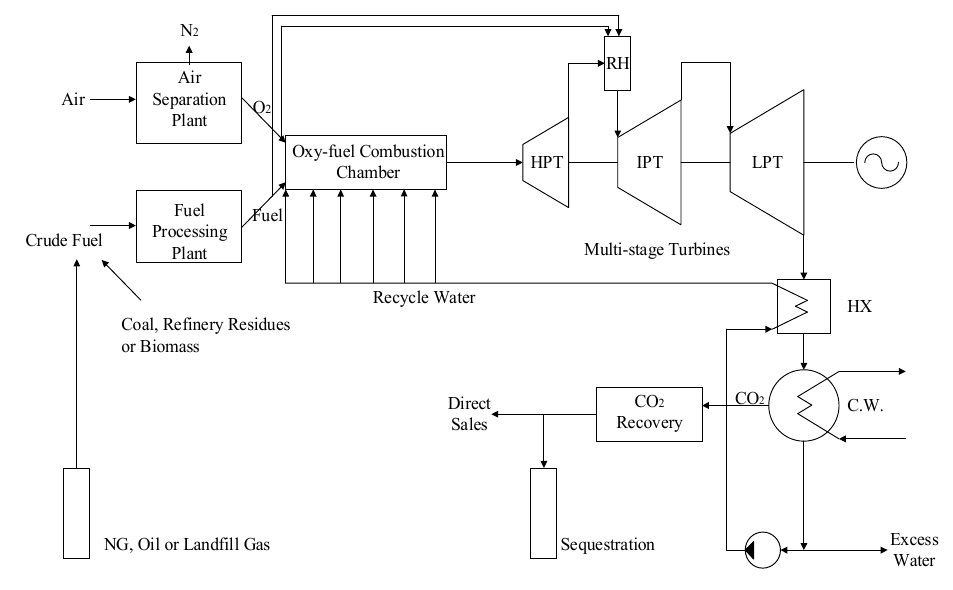
Figure 10. CES cycle concept flow diagram.